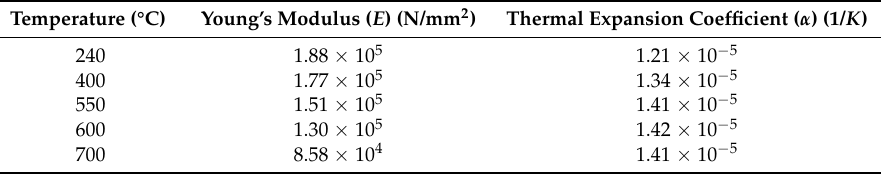
Table 1. A summary of the temperature-dependent material parameters (representative of a P91 chrome steel), determined through experimental analysis, used in the FEA modelling.